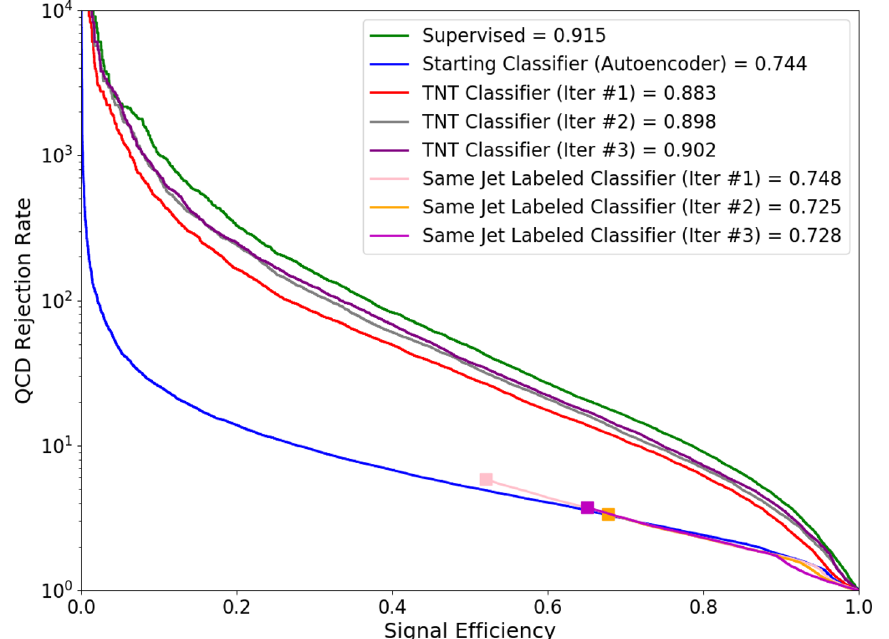
Figure 7 . A comparison of classifiers trained using the same jet repeated versus the TNT approach. The ROC curves of the same-jet-trained classifiers are truncated because selections tighter than this point are not possible due to the classifier scores of these events all being exactly the